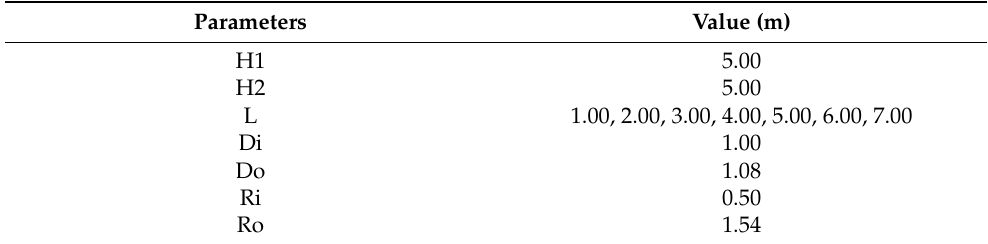
Figure 1. Schematic diagram of 3D geometric model and grid element. Table 2. The dimensions and units of the three-dimensional geometric models.